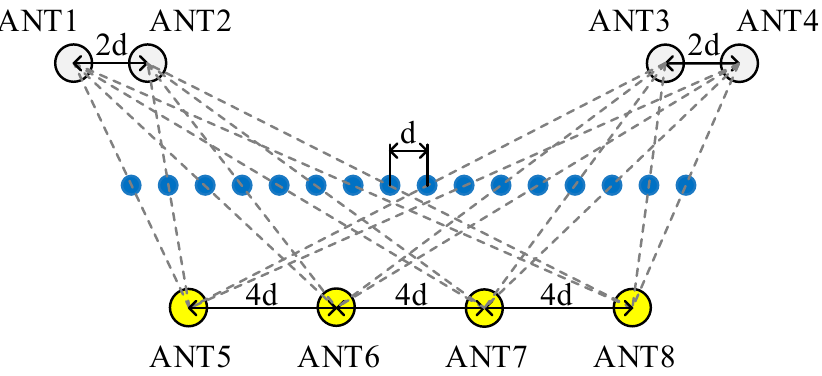
Figure 4. Synthetization of the virtual array.